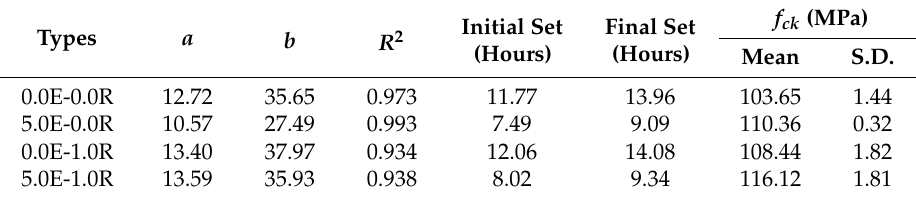
Table 4. Setting properties and compressive strength ( f ck ).